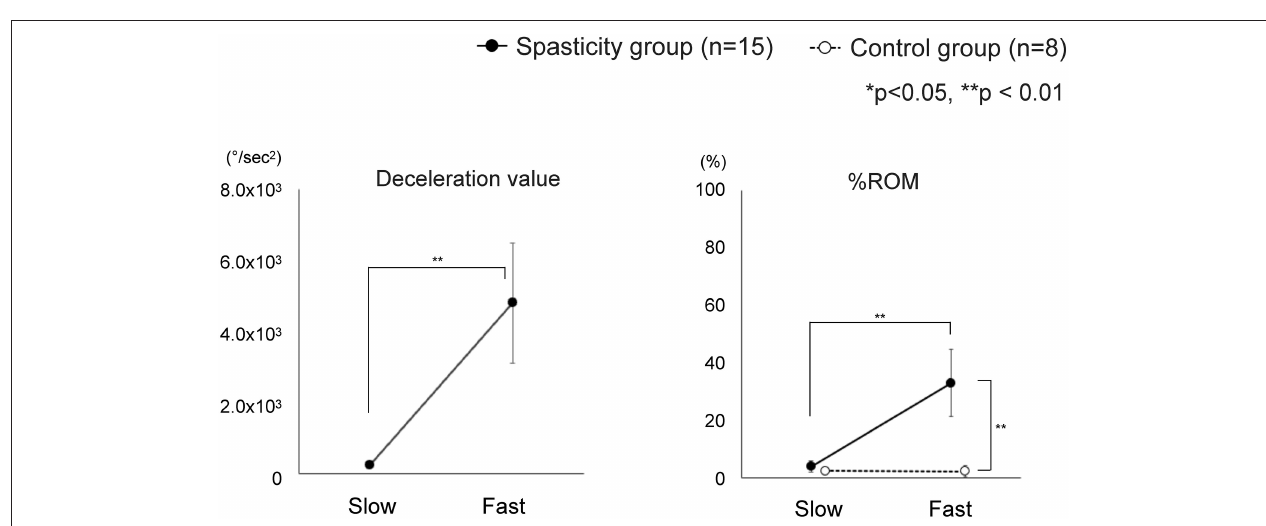
FIGURE 3 | Change in index values between Slow and Fast conditions. The spasticity group showed significant differences in all index values between Slow and Fast. Comparison between the spasticity group and the control group showed significant difference in the Fast condition for %ROM. * Slow: The minimum speed among the